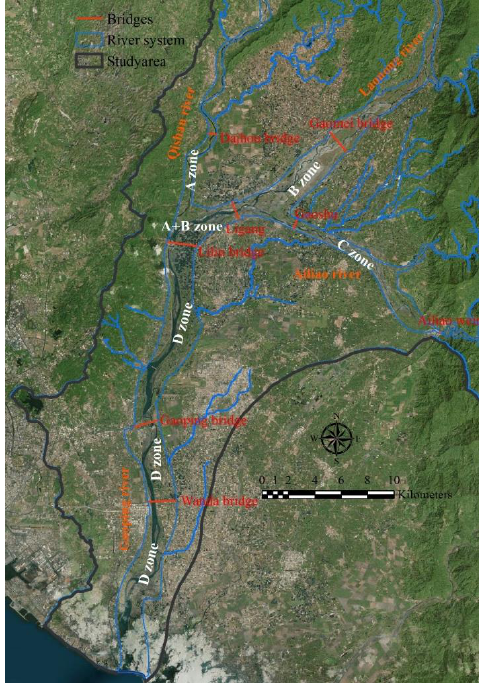
Figure 19. Location of various river sections in the Gaoping River basin that are vulnerable to soil deposition.